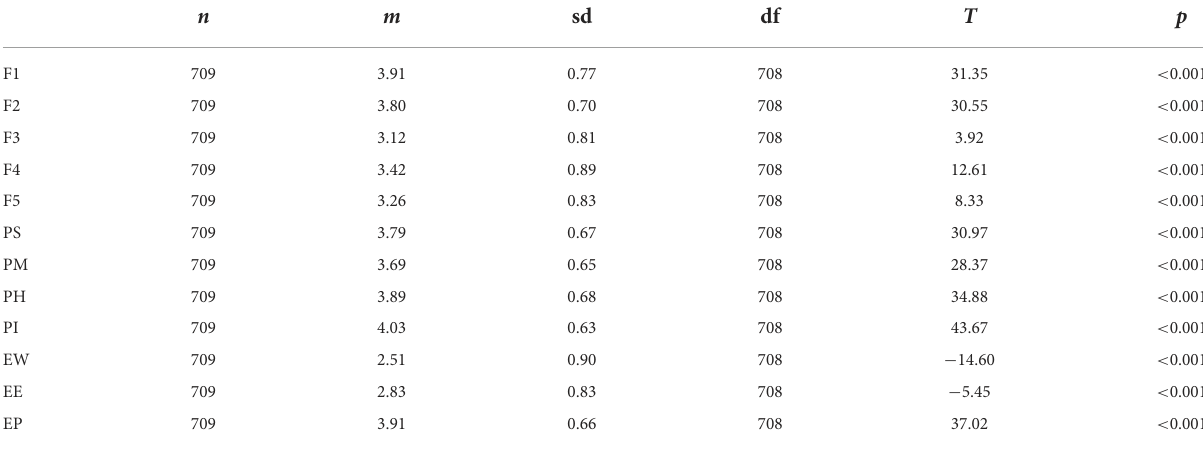
TABLE 2 Descriptive statistics for family quality of life, parental involvement, and stress.